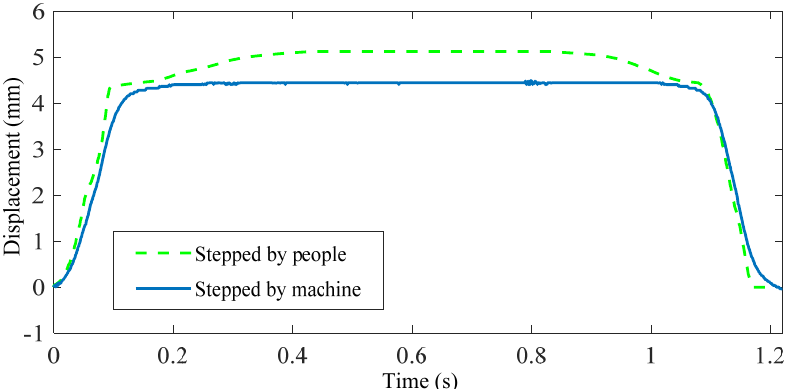
Figure 10. Comparison of the original displacement curve and output displacement curves.